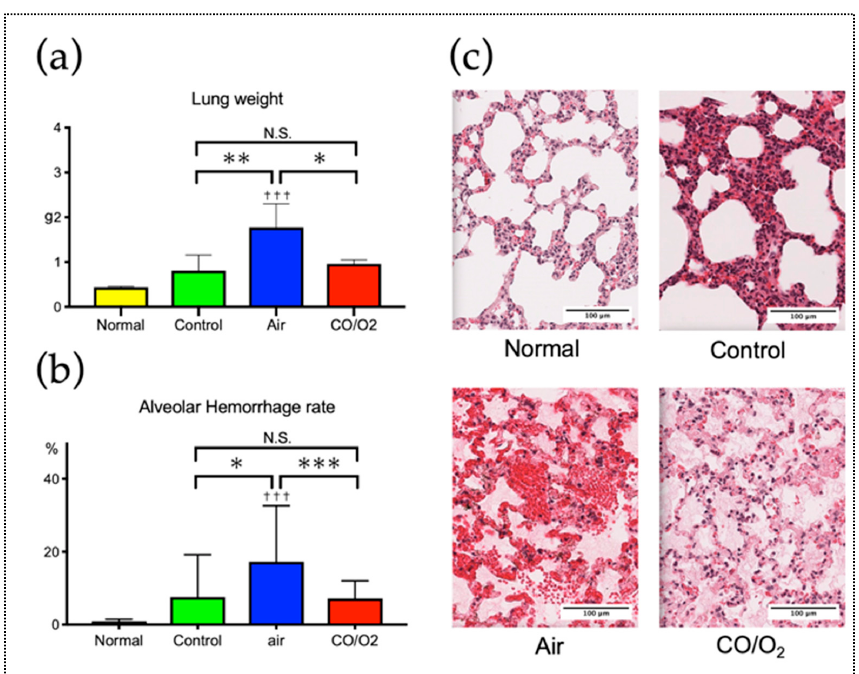
Figure 2. Assessment of rat lungs in the 24-h preservation model. ( a ) Comparison of the lung weights among the four groups. ( b ) Comparison of the severity of alveolar hemorrhage determined by histological assessment among the four groups. ( c ) Comparison of changes observed by light microscopy among the four groups. Each data of bars are expressed as the means ± standard deviations. N.S.—not significant, *** p < 0.001, ** p < 0.01, * p < 0.05, ††† p < 0.001 compared with the normal group. Black bar = 100 μ m